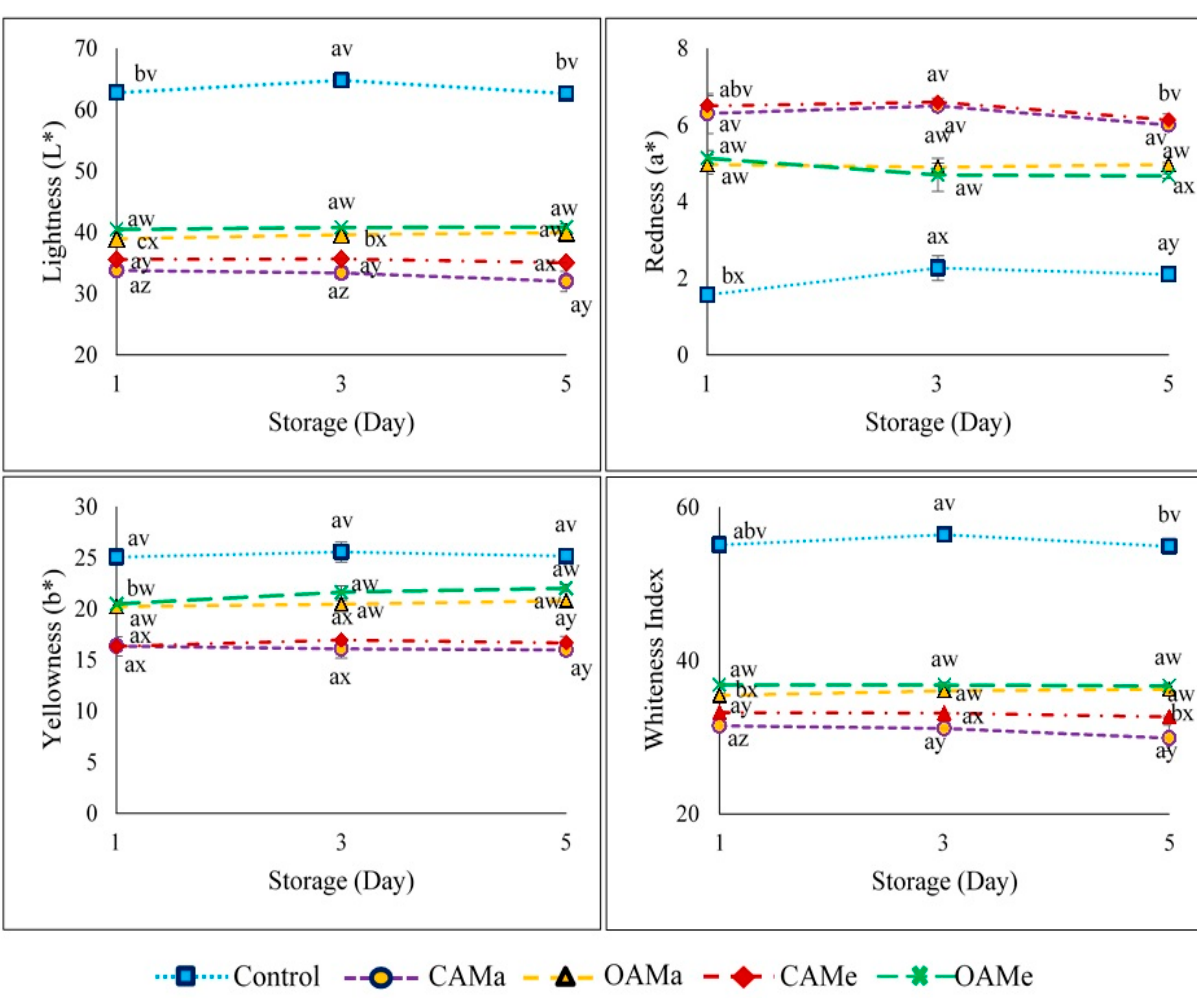
Figure 3. Color properties of muffin. Results are the mean ± standard deviation. Two-way ANOVA: Different letters (a, b, c) show significant differences for each lot at different time ( p < 0.05). Different letters (w, x, y) show significant differences among samples at same time ( p < 0.05).